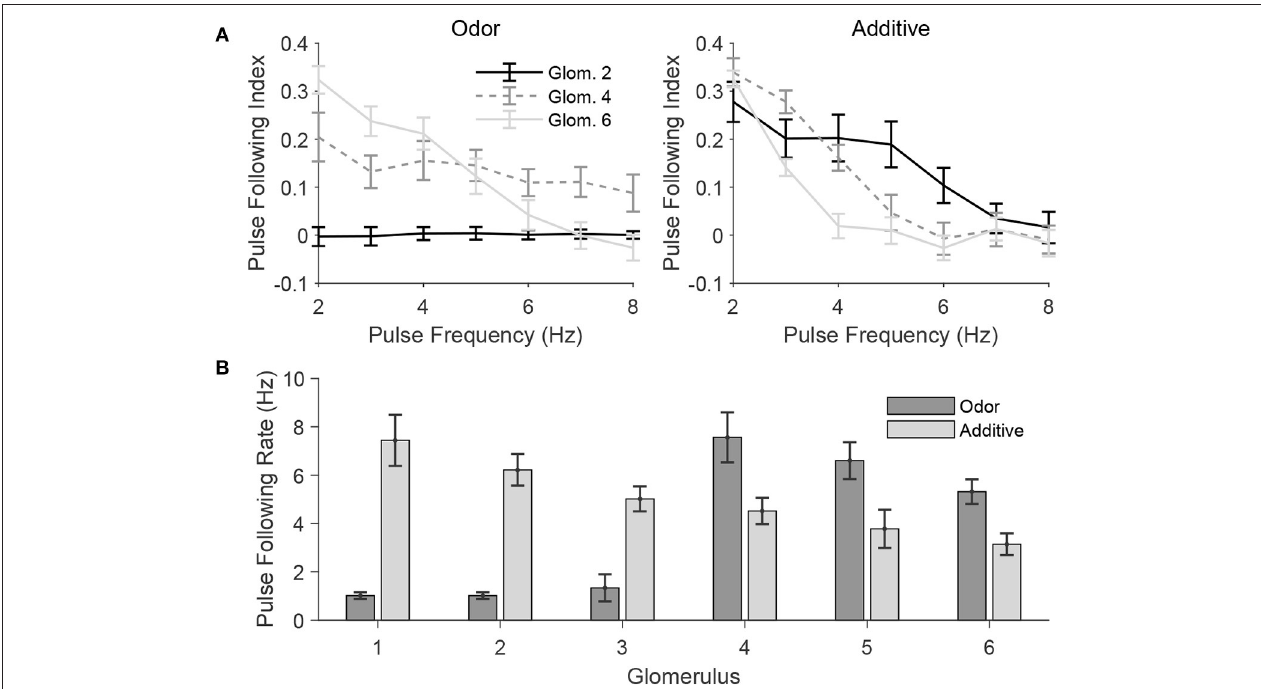
FIGURE 8 | Pulse frequency tracking in the presence of varied odor tuning across glomeruli. In these simulations, odor is simulated by delivering odor-induced stimulus current to glomeruli 1, 2, 3, 4, 5, and 6 at 0, 0.2, 0.4, 0.6, 0.8, and 1, respectively, times the strength of the odor-induced stimulus current in the standard network (for those glomeruli in the standard network that are stimulated by odor). The total level of odor-induced excitation to the entire network is similar to that in the standard network, except with excitation delivered in a graded manner across glomeruli rather than three glomeruli receiving fixed positive excitation and the other three glomeruli receiving no excitation. (A) Pulse following index of net PN activity within a glomerulus plotted as a function of pulse frequency for several glomeruli, in the absence (left; Odor) or presence (right; Additive) of mechanosensory input. (B) Pulse following rate of net PN activity within a glomerulus for each glomerulus in the network, in the absence (Odor) or presence (Additive) of mechanosensory input. Data are averaged over 50